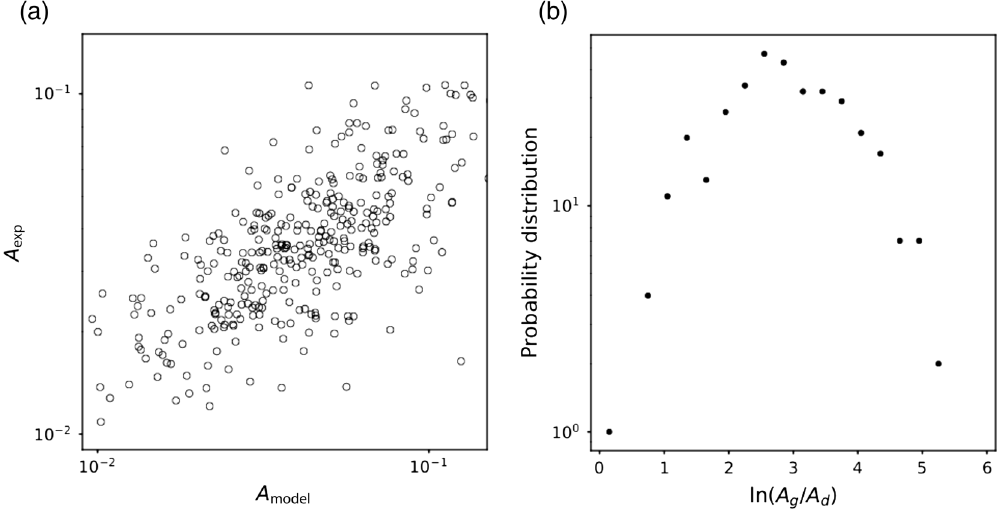
FIG. 6. Fluctuation strength (prefactor in TL) A from experiments and model. (a) Comparison of A obtained from direct measurements ( A ) and from model ( A ) for individual cells (circles) across different promoters and different growth conditions. (b) Distribution exp model =A of the log-ratio [ln ð A ] for all individual cells. A g d Þ division, are obtained from our model. It is clear that A